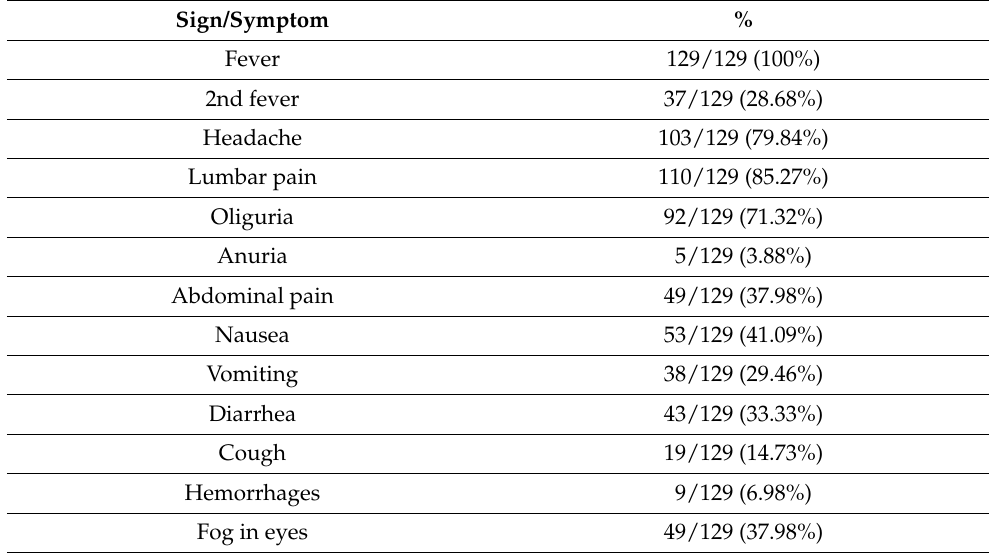
Table 1. Clinical signs and symptoms in adult NE patients.